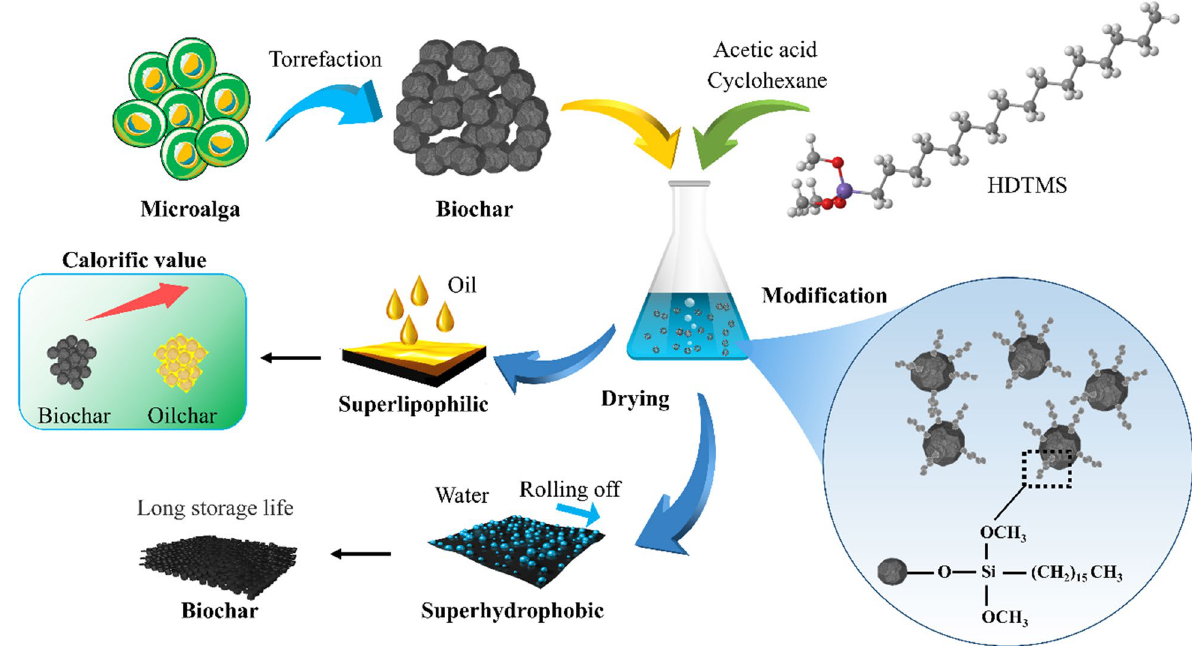
Fig. 1 Schematic of microalgal biochar preparation, modification, and superlipophilicity and superhydrophobicity